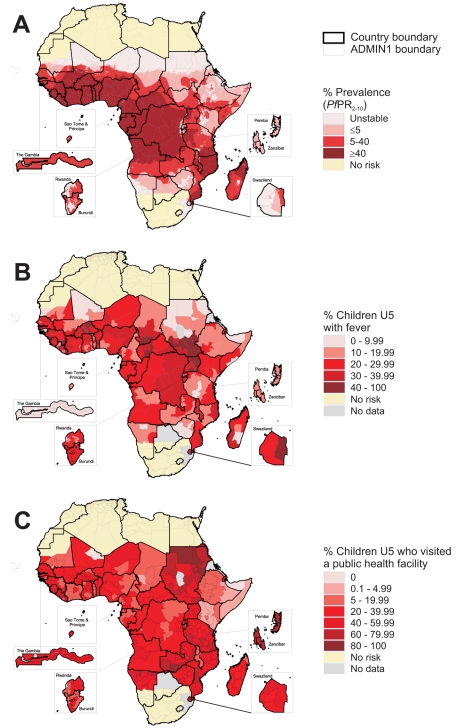
Transmission intensity, fevers, and care seeking for fever across Africa.(A) Predicted transmission intensity across Africa. Transmission is classified into areas of risk free, unstable, and stable transmission on the basis of country-reported case data and the limiting effects on transmission of aridity and low temperatures [38]. The latter class is further divided into low, medium, and high transmission settings from a model-based geostatistical prediction of P. falciparum prevalence in the epidemiologically informative 2-y up to 10-y age range, PfPR2–10
[34]. (B) 14-d period prevalence of reported fevers among children aged 0–4 y derived from national sample survey data (yellow, no risk; grey, no data). (C) Proportion of paediatric fevers using a public health facility at some stage of the illness to treat the fever (yellow, no risk; grey, no data). Footnote: The reference ADMIN1 digital boundaries for Africa were obtained through a combination of data from the United Nations Geographic Information Working Group, Second Administrative Level Boundary project (UNGIWG-SALB [56]) and the Food & Agriculture Organization - Global Administrative Units Layers (FAO-GAUL [57]). These boundary units matched reported information on fever prevalence for 31 of 42 national survey reports assembled. For Angola, Burundi, Central African Republic, Chad, Congo, Gabon, Guinea Bissau, Mauritania, and Nigeria nonstandard ADMIN1 units were reported by the national sample surveys and these were digitized using ArcGIS 9.3 (ESRI, Inc.) to replace existing ADMIN1 boundaries and thus create a single fever spatial reporting surface, similar to recent approaches to assemble mosquito net use from national survey data [58].